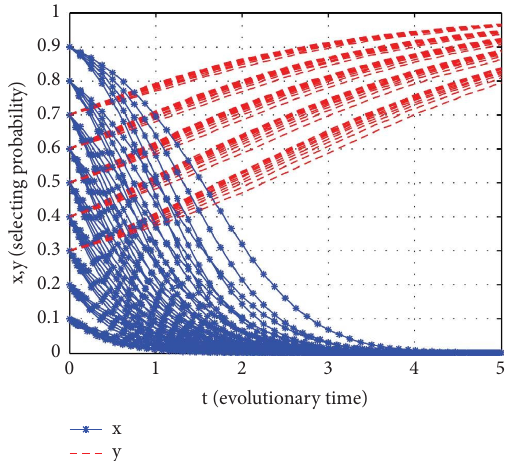
Figure 7: Te evolutionary consequences of Proposition 4 (a).